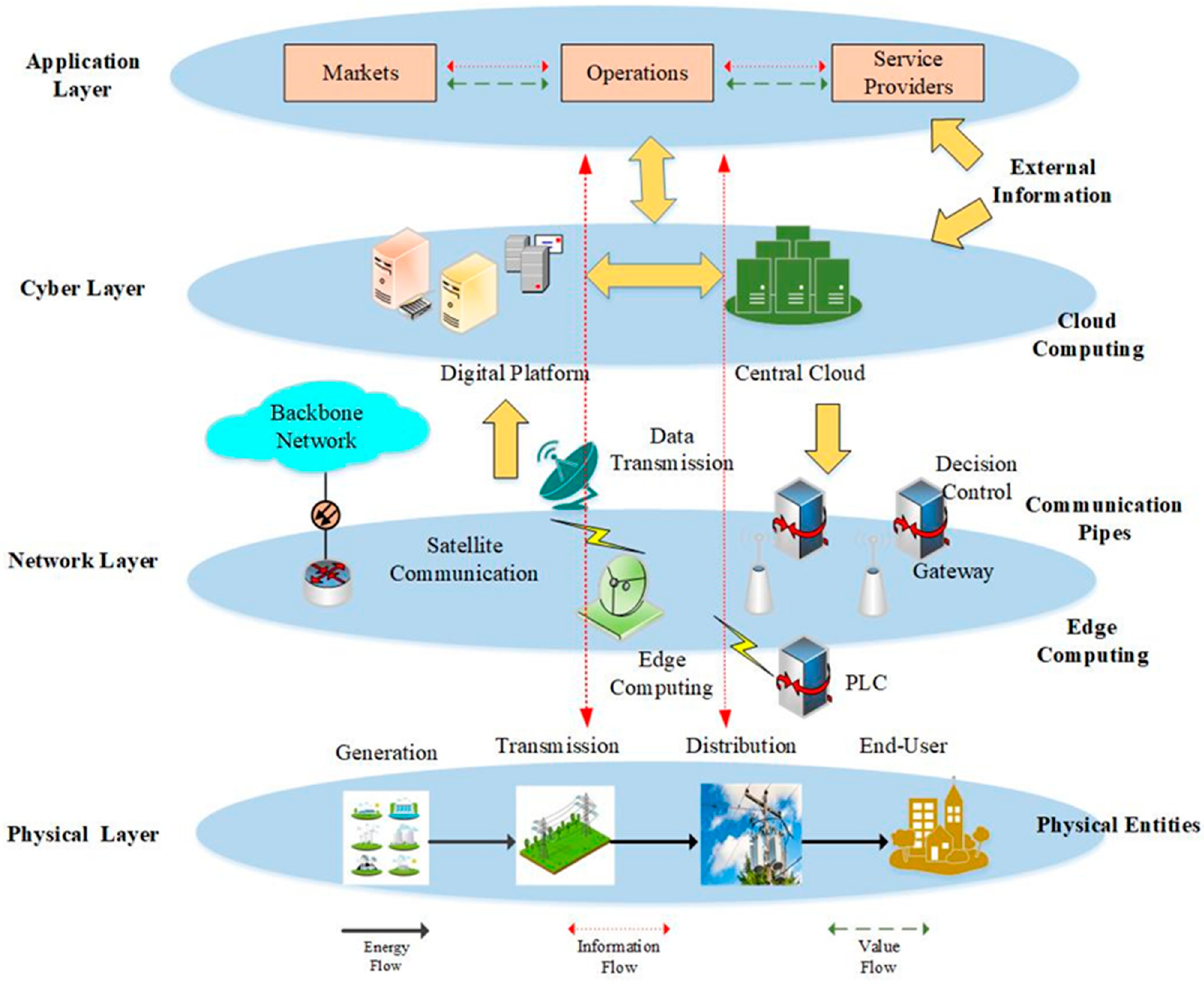
Figure 4. Four-layered architecture for the IoT-enabled smart